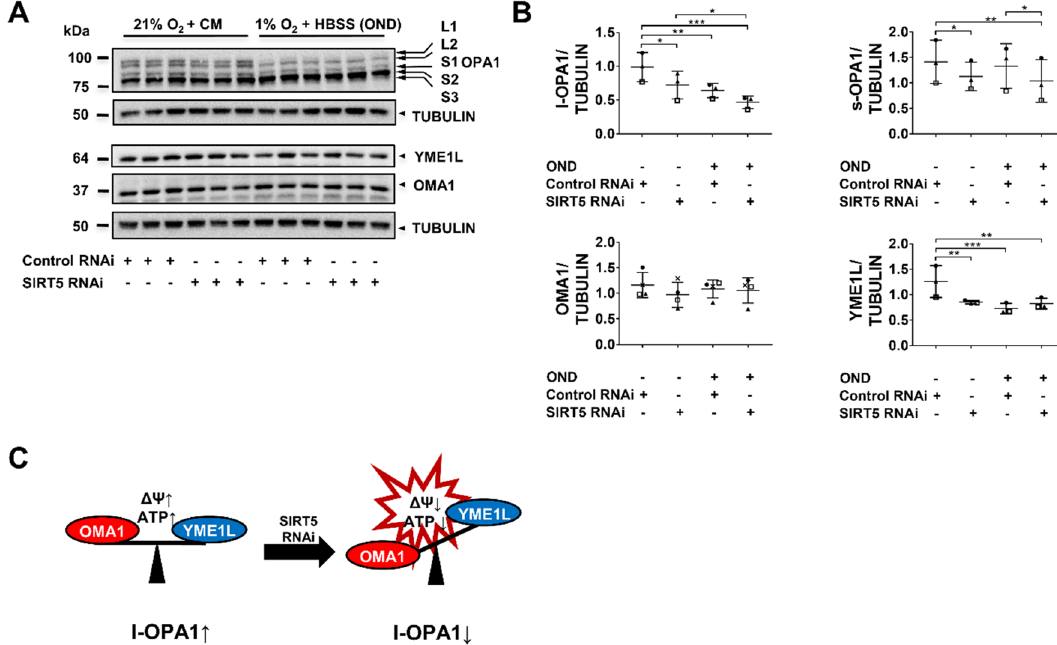
Figure 4. SIRT5 -knockdown affects OPA1 processing by OMA1 and YME1L. hPTECs were transfected with siRNA against SIRT5 or non-targeting siRNA control. Seventy-two hours post-transfection cells were exposed to 6 h OND (1%O 2 + HBSS) or normoxia and complete medium (21%O 2 + CM). ( A ) WBs showing protein levels of OPA1 (five isoforms: L1, L2, S1–3) and the OPA1 processing proteases, OMA1 (ATP-independent) and YME1L (ATP-dependent). Whole WBs shown in supplementary file (Supplementary Fig. S8f) ( B ) Scatter plots showing densitometric quantitation of long (l)-OPA1, short (s)-OPA1, OMA1 and YME1L. Data are from three to four independent experiments with n = 3 replicates/group. Tubulin was used as loading controls. ImageJ was used for densitometric analysis. To determine statistical significance a two-way ANOVA was carried out followed by Tukey’s post hoc test to normalize for multiple comparisons. Data are mean ± SD. *p < 0.05, **p < 0.01, and ***p < 0.001. ( C ) Schematic of the proposed model of SIRT5 RNAi-induced l-OPA1 processing by OMA1